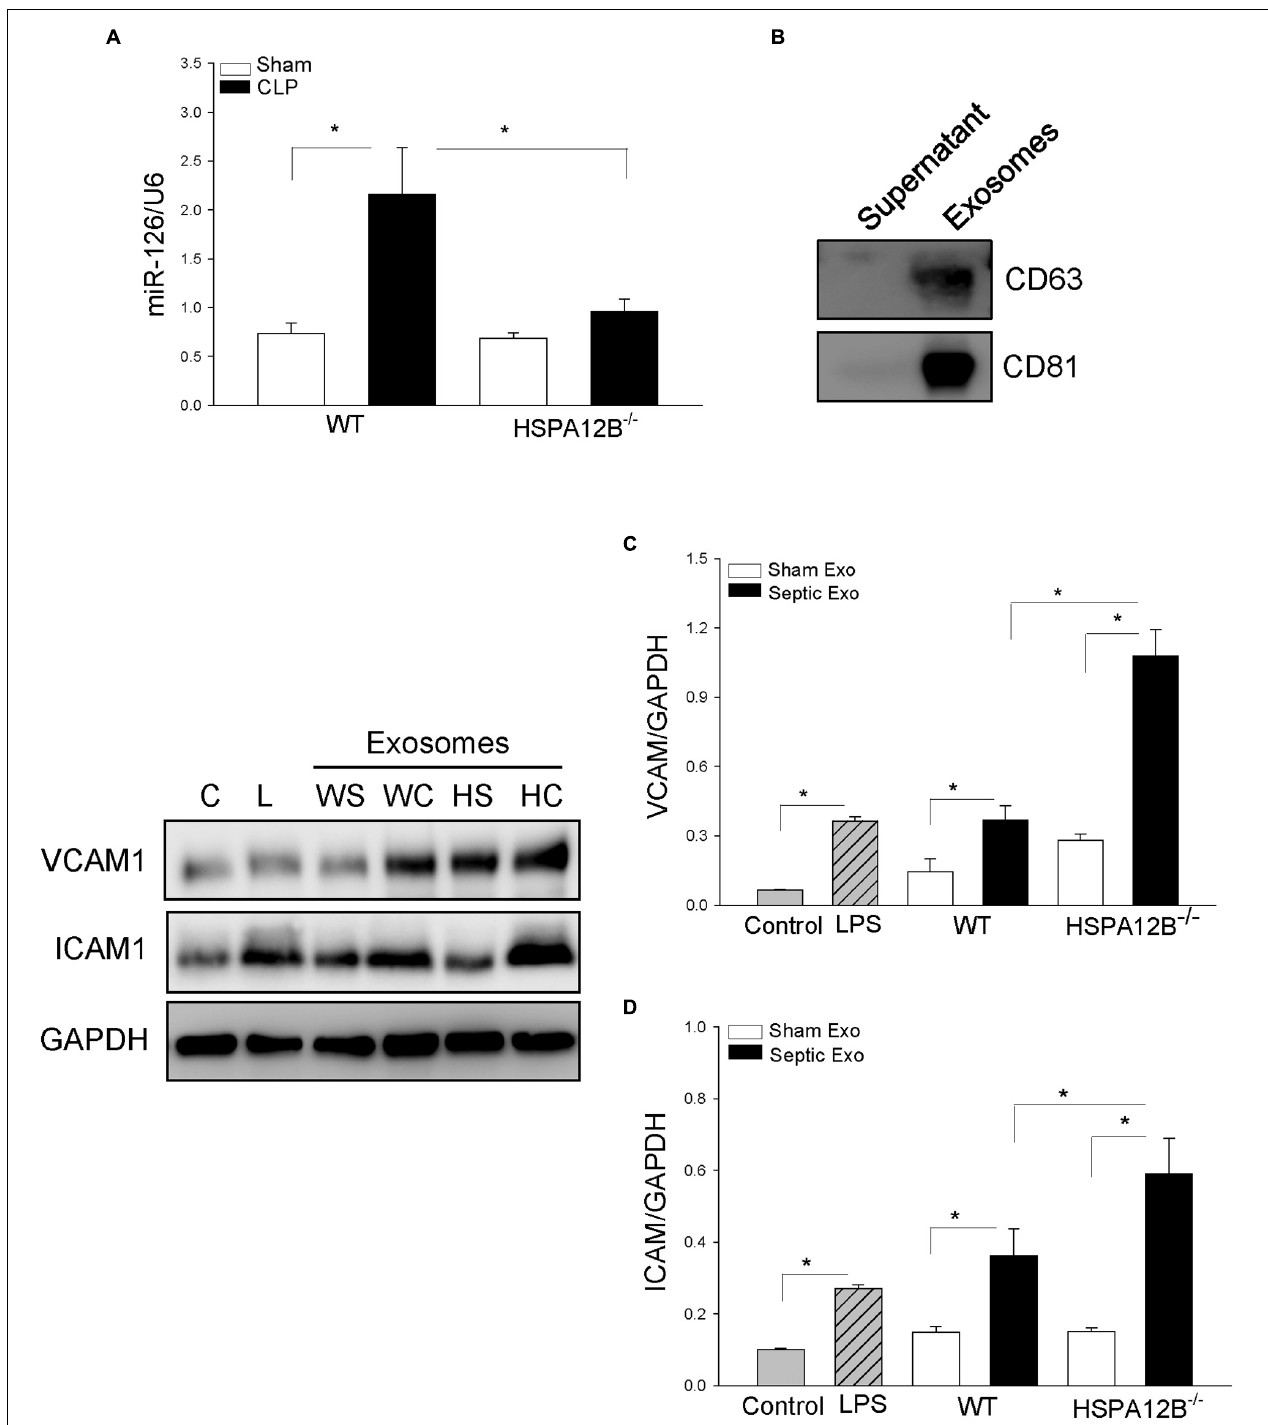
FIGURE 5 | Serum exosomes from HSPA12B − / − septic mice increased expression of adhesion molecules in endothelial cells. Wild-type and HSPA12B − / − mice were subjected to CLP sepsis or sham surgical operation. Ten hours after CLP, blood was collected for the isolation of serum exosomes with ExoQuick exosome isolation kit. (A) miR-126 levels in the isolated serum exosomes were examined by qPCR. (B) Exosome markers (CD63 and CD81). (C) Endothelial cells (HUVEC) were treated with isolated exosomes for 12 h. The cells were harvested for analysis of VCAM-1 (C) and ICAM1 (D) by Western blot ( n = 4–6/group). C, control; L, LPS; WS, WT sham; WC, WT CLP; HS, HSPA12B − / − sham; HC, HSPA12B − / − CLP; Exo, exosomes. ∗ P < 0.05 compared with indicated groups.